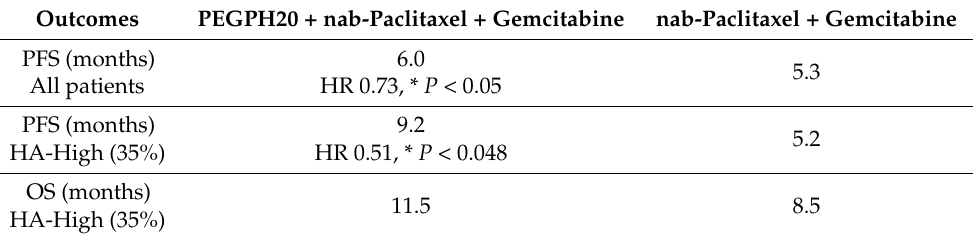
Table 1. Results of a phase II clinical study to investigate pegylated hyaluronidase in combination